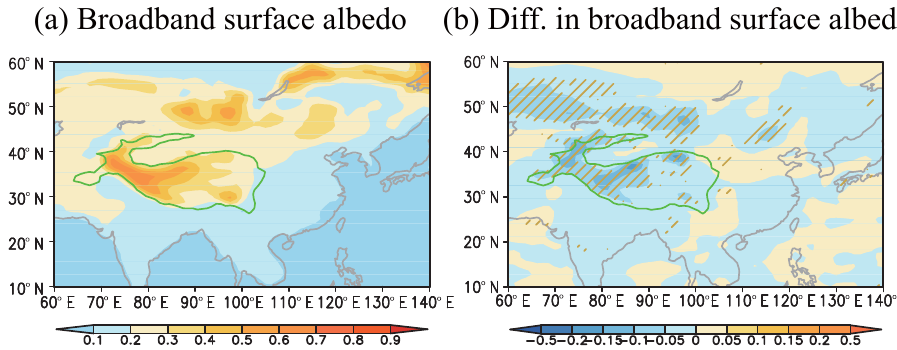
Figure 6. (a) Spatial distribution of the broadband surface albedo in MAM (Case1) and (b) its changes between Case1 and Case2, which are induced by dust-in-snow radiative forcing (SRF). The slanted lines represent the grid points where the changes pass the two-tailed t test at the 5% significance level. The green outlined area indicates the plateau above